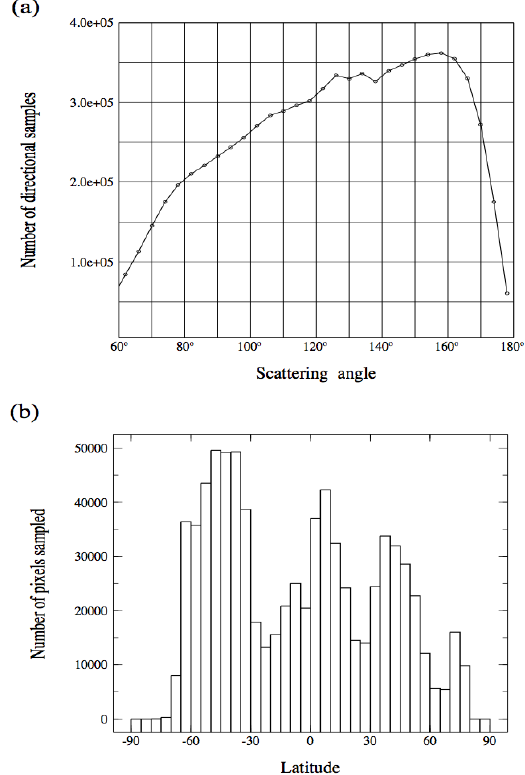
Figure 2. (a) Angular distribution and (b) latitude distribution of the sample